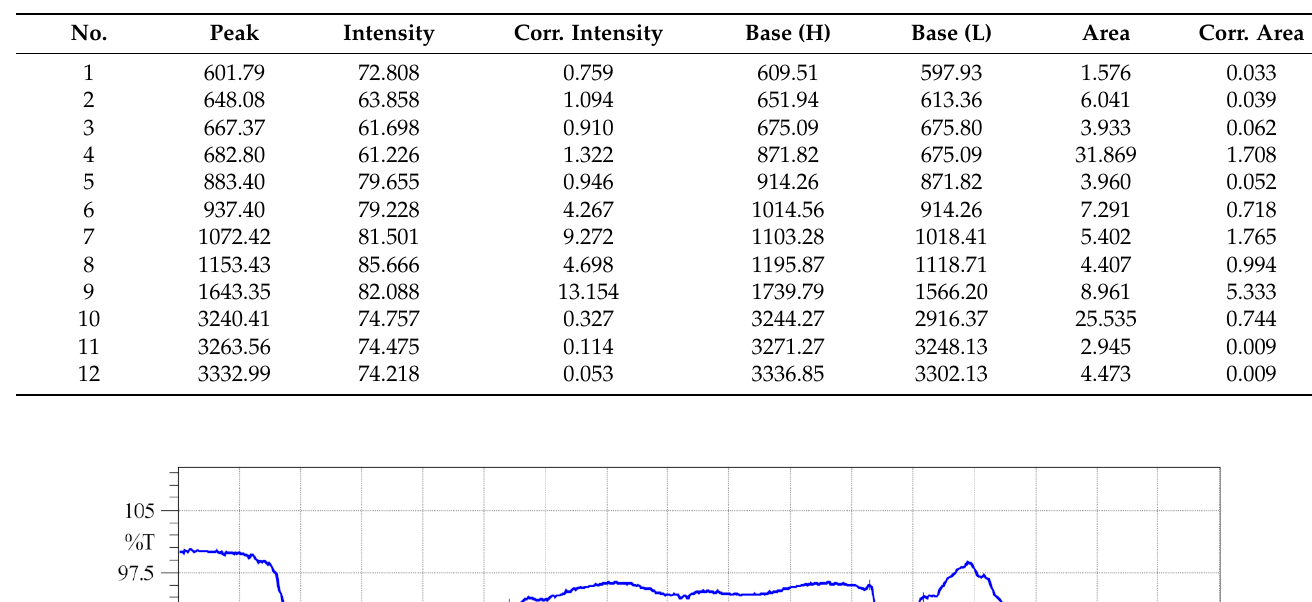
Table 8. Peaks of the IR spectra of potassium humate.